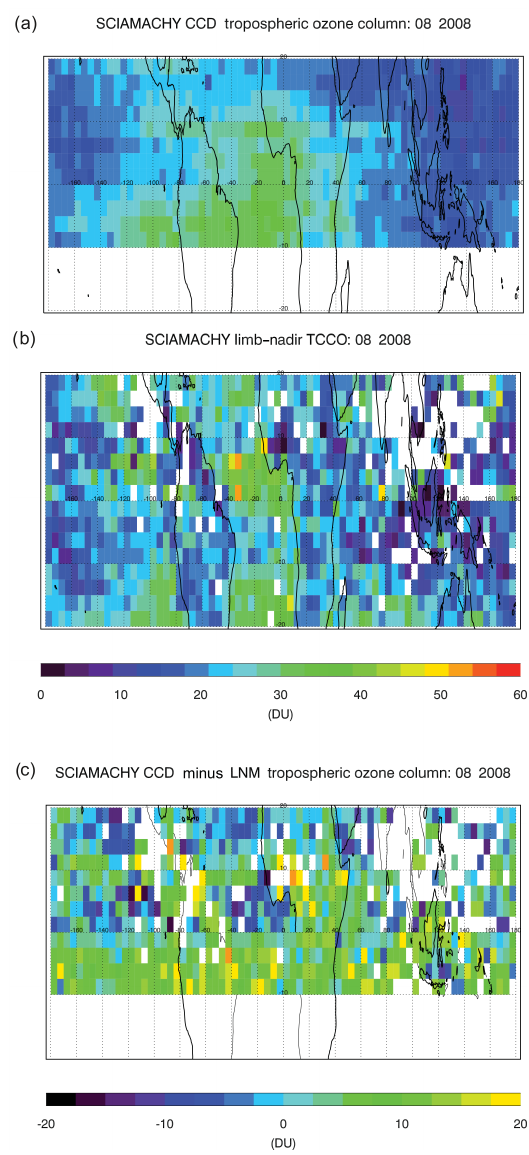
Figure 15. (a) Tropical tropospheric ozone column from CCD SCIAMACHY for August 2008. (b) SCIAMACHY tropical tropo- spheric ozone column from limb/nadir matching technique up to 200 hPa for August 2008. (c) Difference between CCD and LNM SCIAMACHY data in August